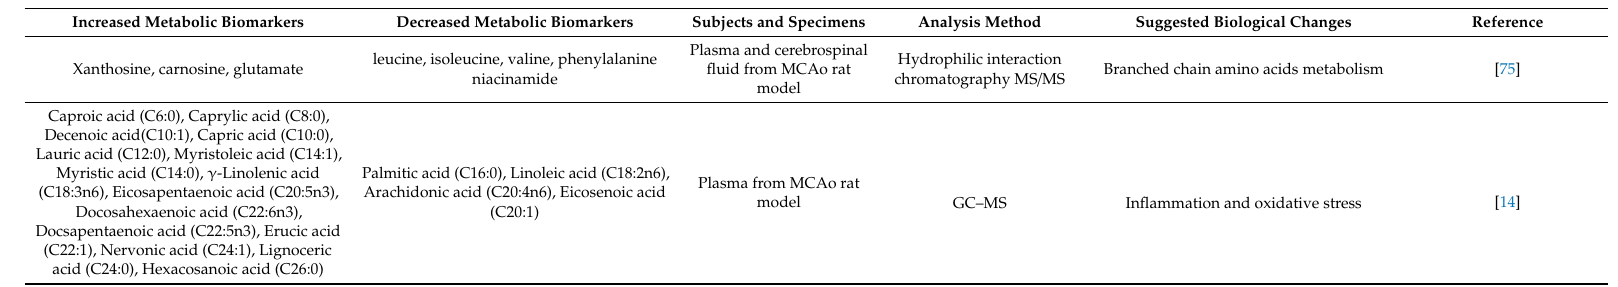
Table 2. Summary of metabolites associated with MCAo in the rat